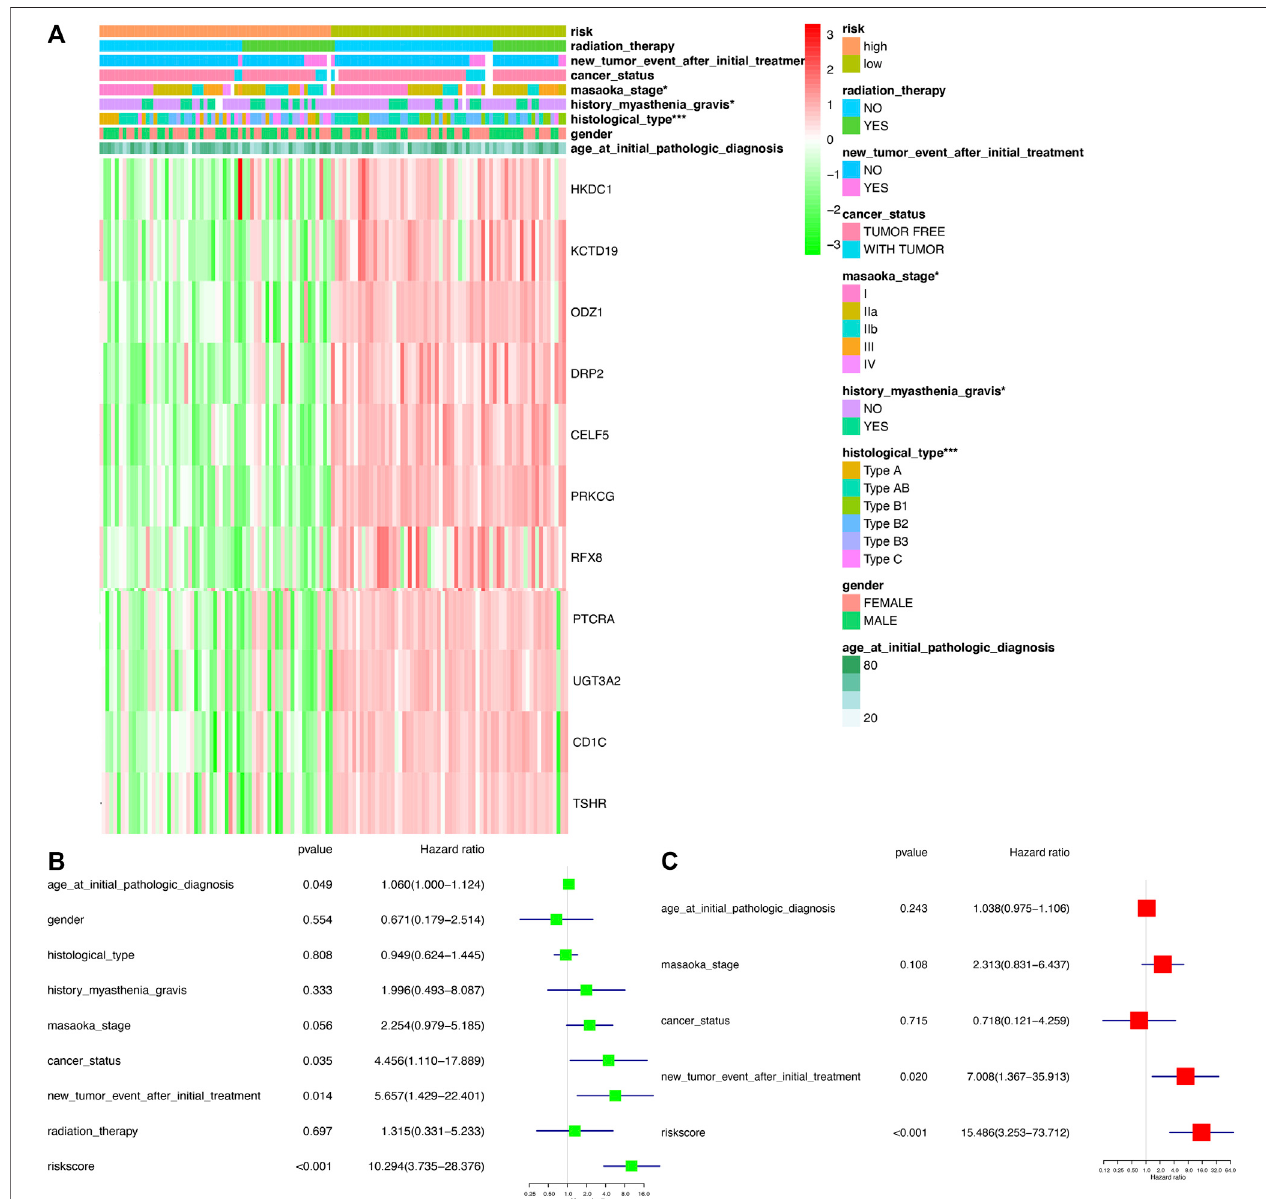
FIGURE 7 | The clinical correlation between clinical features and risk score in THYM. (A) Heatmap of the clinical correlation between high- and low-risk score groups in THYM. (B) Univariate Cox regression analysis of risk factors in THYM. (C) Multivariate Cox regression analysis of risk factors in THYM. * p < .05, ** p < .01, and *** p <